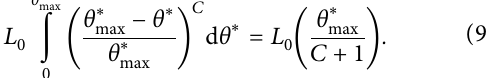
Table 2: Statistical table of relevant parameters of direction roughness L Forward